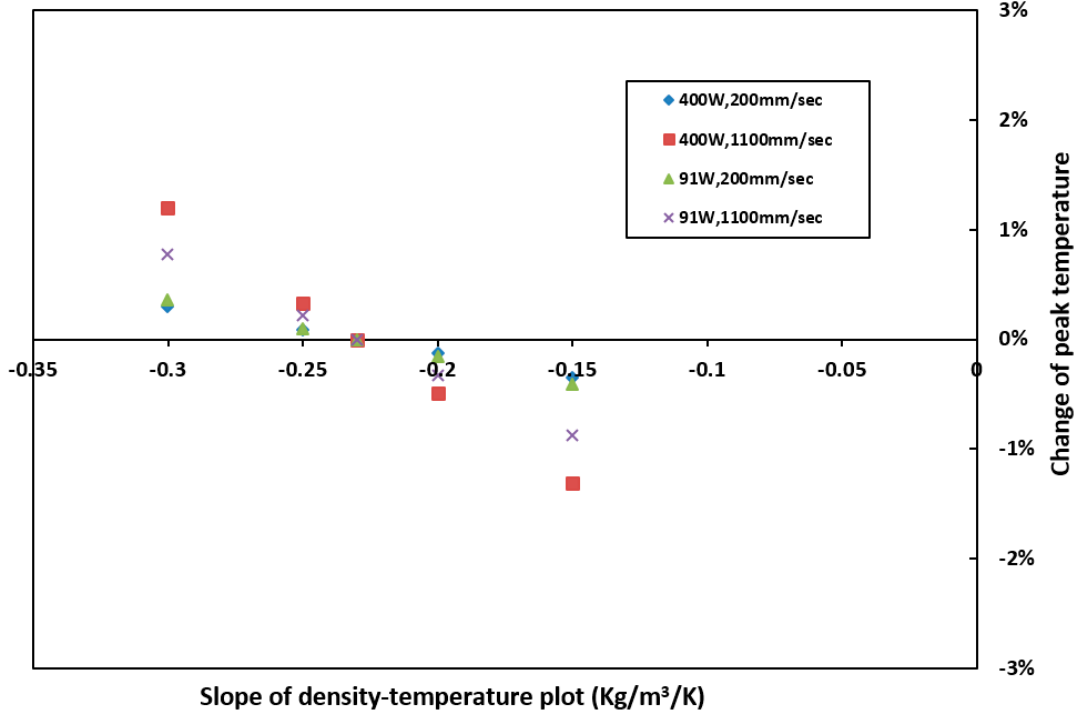
Figure 13. Sensitivity of peak temperature to density. Percentage change of peak temperature with respect to that calculated with base density at different process parameters .